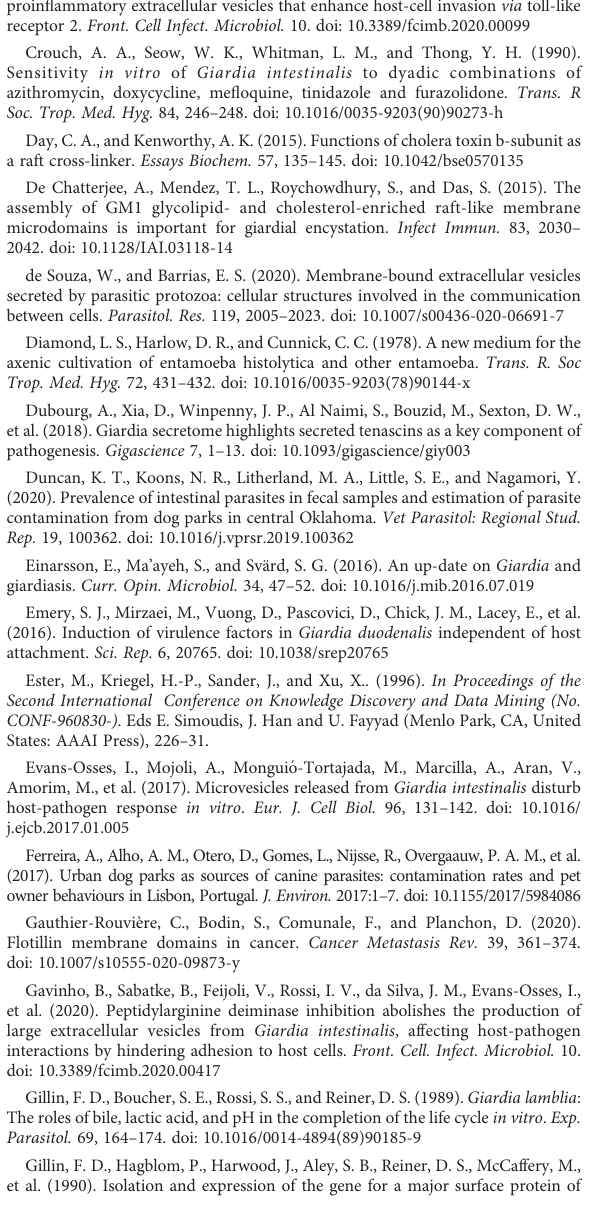
SUPPLEMENTARY TABLE 5 Differentially expressed virulence proteins processed through ScaffoldQ+ SUPPLEMENTARY TABLE 6 All virulence proteins from proteomic analysis from lipid rafts, large vesicles and small vesicle were shown in one table. The table includes